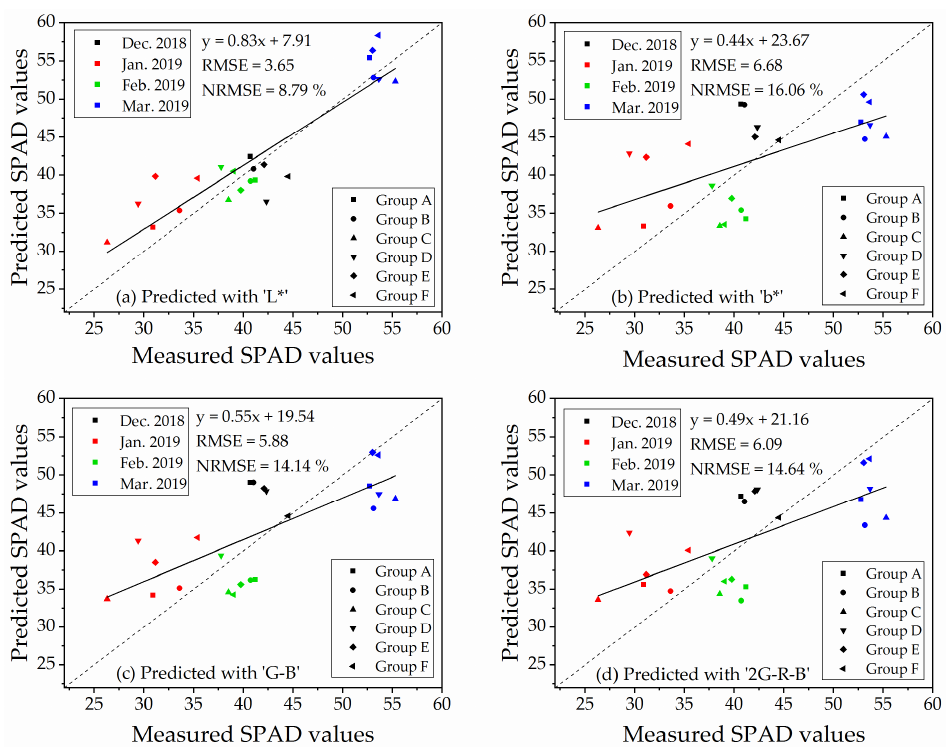
Figure 9. Validation of the four models for estimating of SPAD values at the flight height of 6.0 m (n = 23).